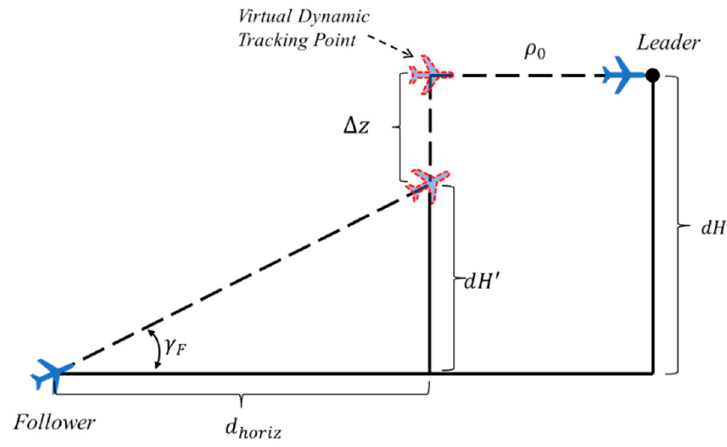
Figure 2. Vertical motion of the leader–follower formation model.